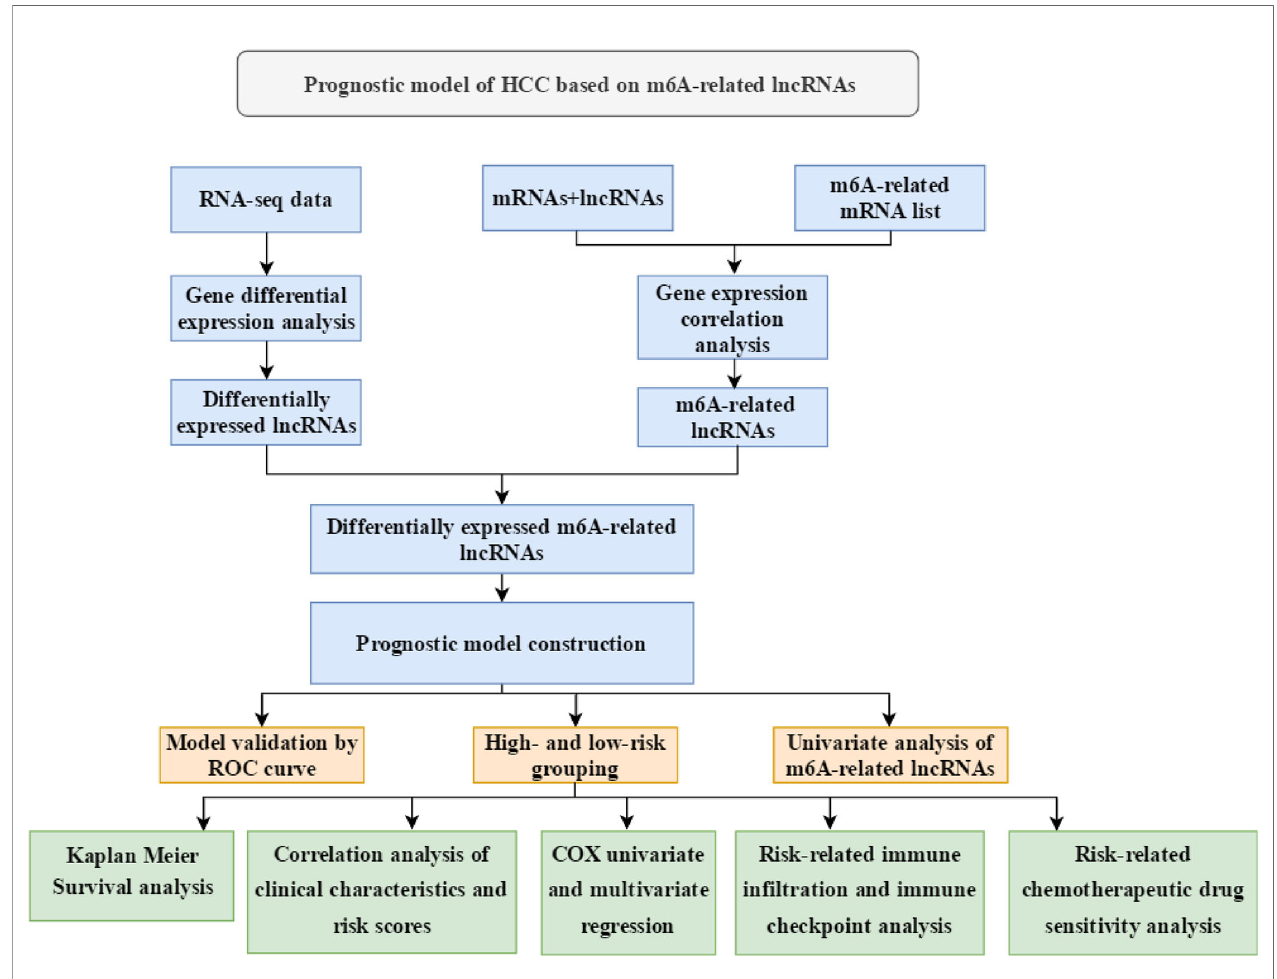
FIGURE 1 | Technical roadmap in this